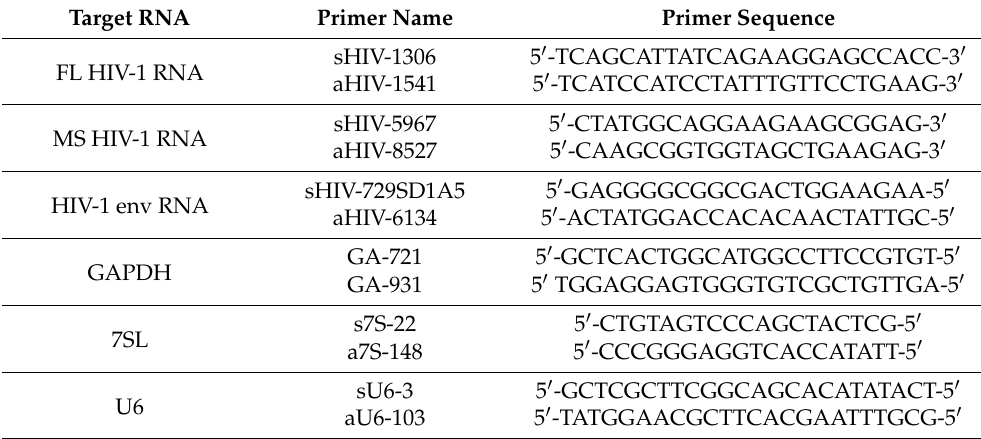
Table 1. List of primer used in